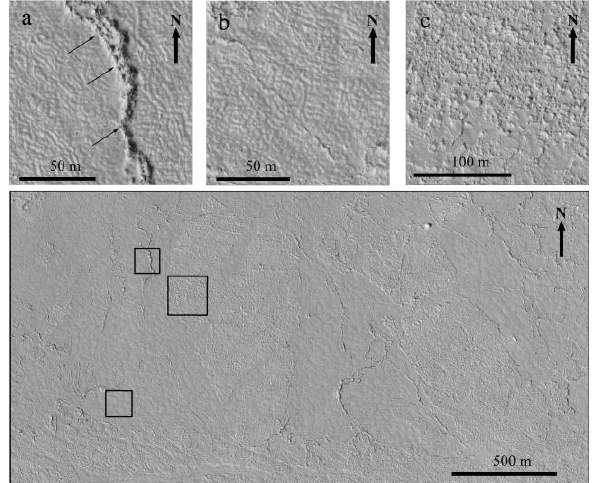
Figure 1. Platy-ridged-polygonised terrain (Part of HiRISE image PSP_003571_1880_RED.jp2). The ridges are highlighted by arrows and in inset (a) in detail, the smoother material are the polygonised terrain (labelled by PO and shown in inset (b) in detail), and the rougher material is the platy terrain (labelled by PL and highlighted in inset (c)). interpreted the ridges to be ice pressure ridges while the plates were slabs of sediment rich ice rafted along in the debris flow. Based on morphology, size, and an analogy with terrestrial ground ice forms, Burr et al. (2005) proposed the ground ice hypothesis for the polygonal terrain and other related